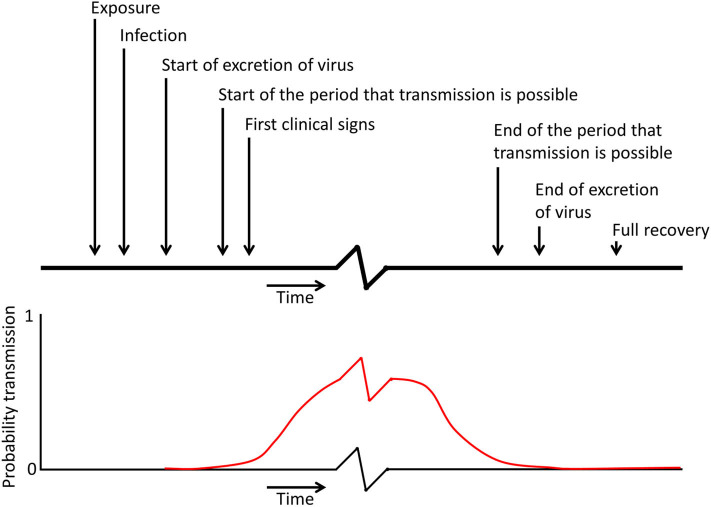
Schematic representation of the different moments in time during infection, which can be used in models to describe the infection process (the x axis and the red curve showing the probability of transmission contain a break as the period in which transmission can occur is probably relatively longer than the other periods indicated on the top of the figure).